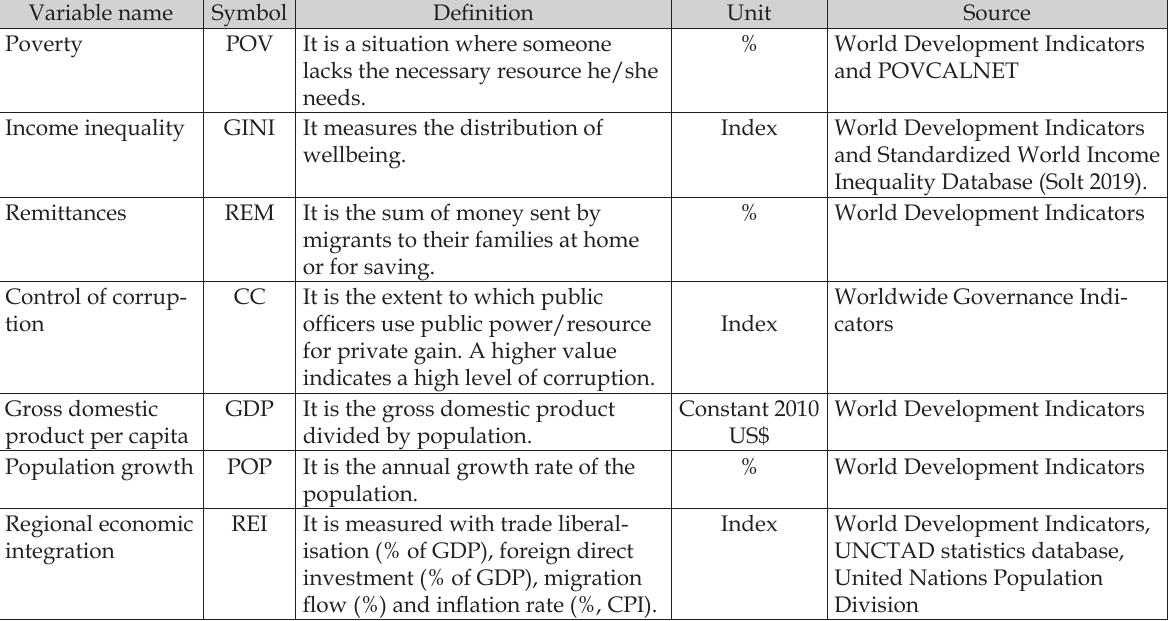
Table 1. Definition and data